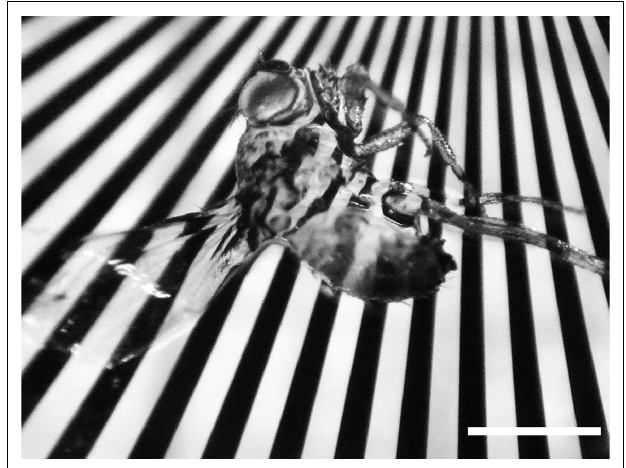
FIGURE 2 | White eyed Drosophila , placed on a Siemens star after dehydration and clearing. The fl y is nearly completely translucent. Length of scale bar 1